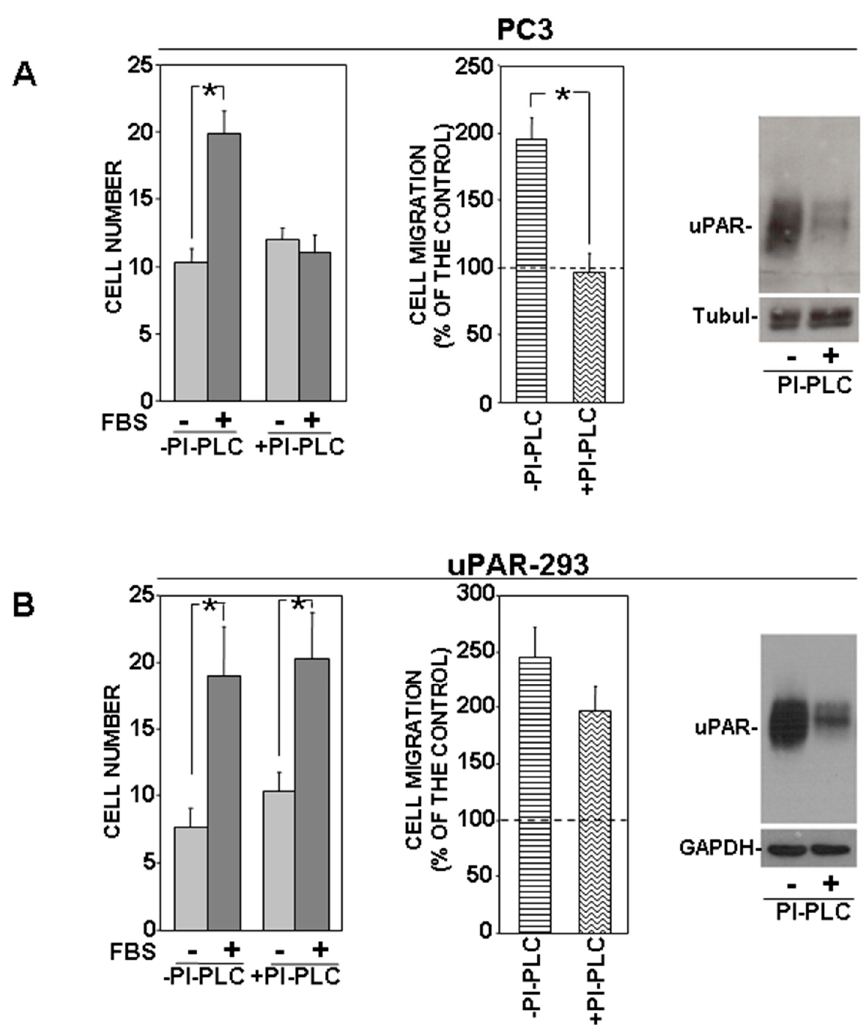
Figure 2. Removal of uPAR GPI-anchor impairs uPAR-controlled mechanism of cell migration. PC3 ( A ) and uPAR-293 ( B ) cells were treated with 1 U / mL of phosphatidylinositol-specific phospholipase C (PI-PLC) or with diluent. Cells were then plated in Boyden chambers and allowed to migrate towards 10% fetal bovine serum (FBS). Migrated cells were fixed, stained with hematoxylin, and counted (left graphs). Results of migration assays are also expressed as percentage of cells migrated towards serum over the cells migrated without serum; 100% values represent cell migration in the absence of chemoattractants (right graphs). The values are the mean ± SD of three experiments performed in triplicate. (*) p ≤ 0.05, as determined by the Student’s t -test. PC3 and uPAR-293 cells treated with or without PI-PLC were also lysed and analyzed by Western blot with an anti-uPAR monoclonal antibody to assess PI-PLC effect; membranes were then reprobed with anti-tubulin or anti-GAPDH rabbit antibodies for loading control (( A , B ), right panels).